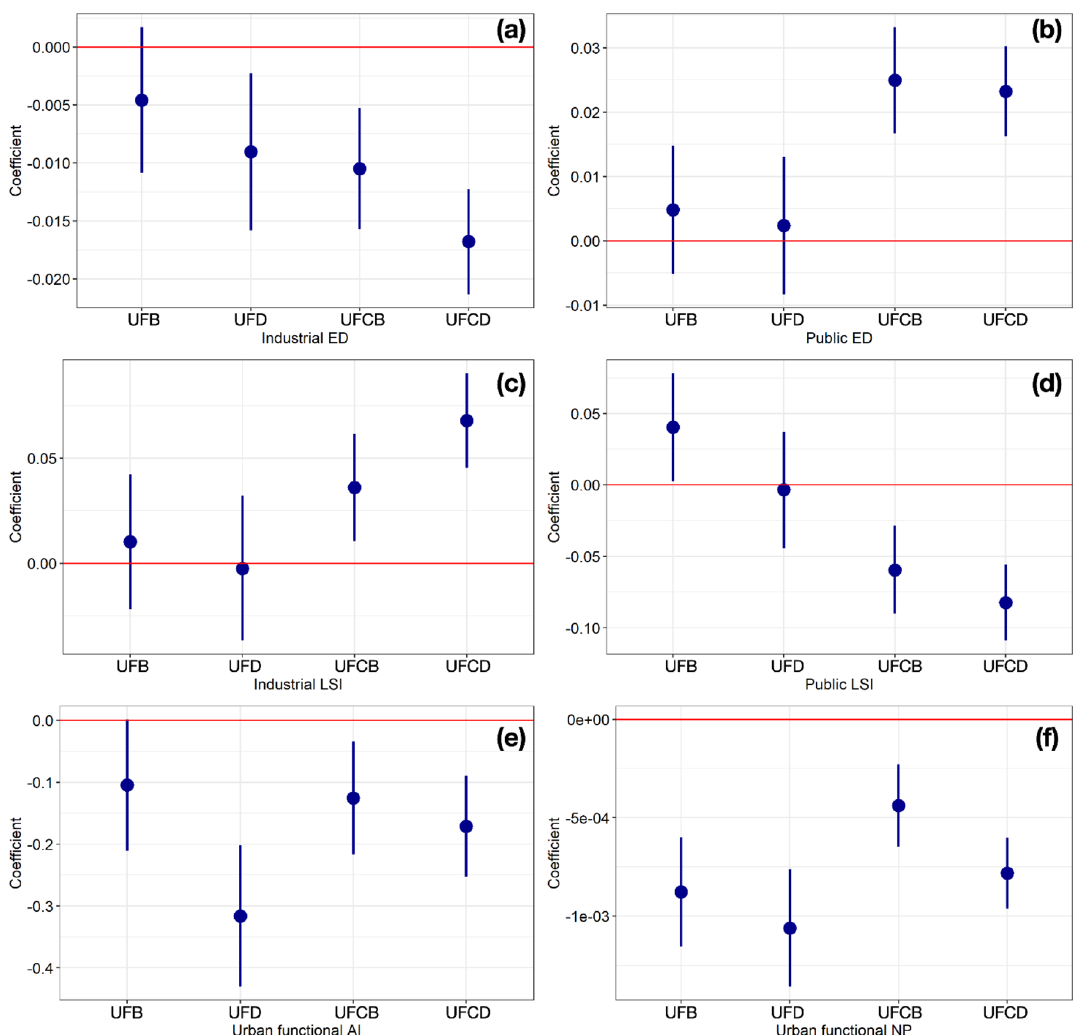
Figure 6. Coefficient changes and 95% CI of urban functional fragmentation characteristics on NO 2 variations based on four models. ( a ) Industrial ED; ( b ) Public ED; ( c ) Industrial LSI; ( d ) Public LSI; ( e ) Urban functional AI; ( f ) Urban functional NP. One unit of industrial ED is associated with − 0.0046 (95% CI − 0.0109 to 0.0017), − 0.0090 (95% CI − 0.0158 to − 0.0023), − 0.0105 (95% CI − 0.0157 to − 0.0053) and − 0.0168 (95% CI − 0.0213 to − 0.0122) NO 2 variations of UFB, UFD, UFCB and UFCD models, respectively. Per unit of public ED is linked with 0.0048 (95% CI − 0.0052 to 0.0148), 0.0024 (95% CI − 0.0083 to 0.0131), 0.0249 (95% CI 0.0166 to 0.0332) and 0.0232 (95% CI 0.0162 to 0.0303) NO 2 variations for four models. NO 2 variations of 0.0103 (95% CI − 0.0218 to 0.0424), − 0.0024 (95% CI − 0.0370 to 0.0321), 0.0360 (95% CI 0.0105 to 0.0616) and 0.0680 (95% CI 0.0454 to 0.0907) of four models are influenced by per unit of industrial LSI. For the public LSI characteristic, one unit of this is associated with 0.0405 (95% CI 0.0026 to 0.0784), − 0.0035 (95% CI − 0.0443 to 0.0373), − 0.0594 (95% CI − 0.0902 to − 0.0287) and − 0.0825 (95% CI − 0.1092 to − 0.0558) NO 2 variations of four models. Per unit of urban functional AI is associated with − 0.1047 (95% CI − 0.2110 to 0.0016), −